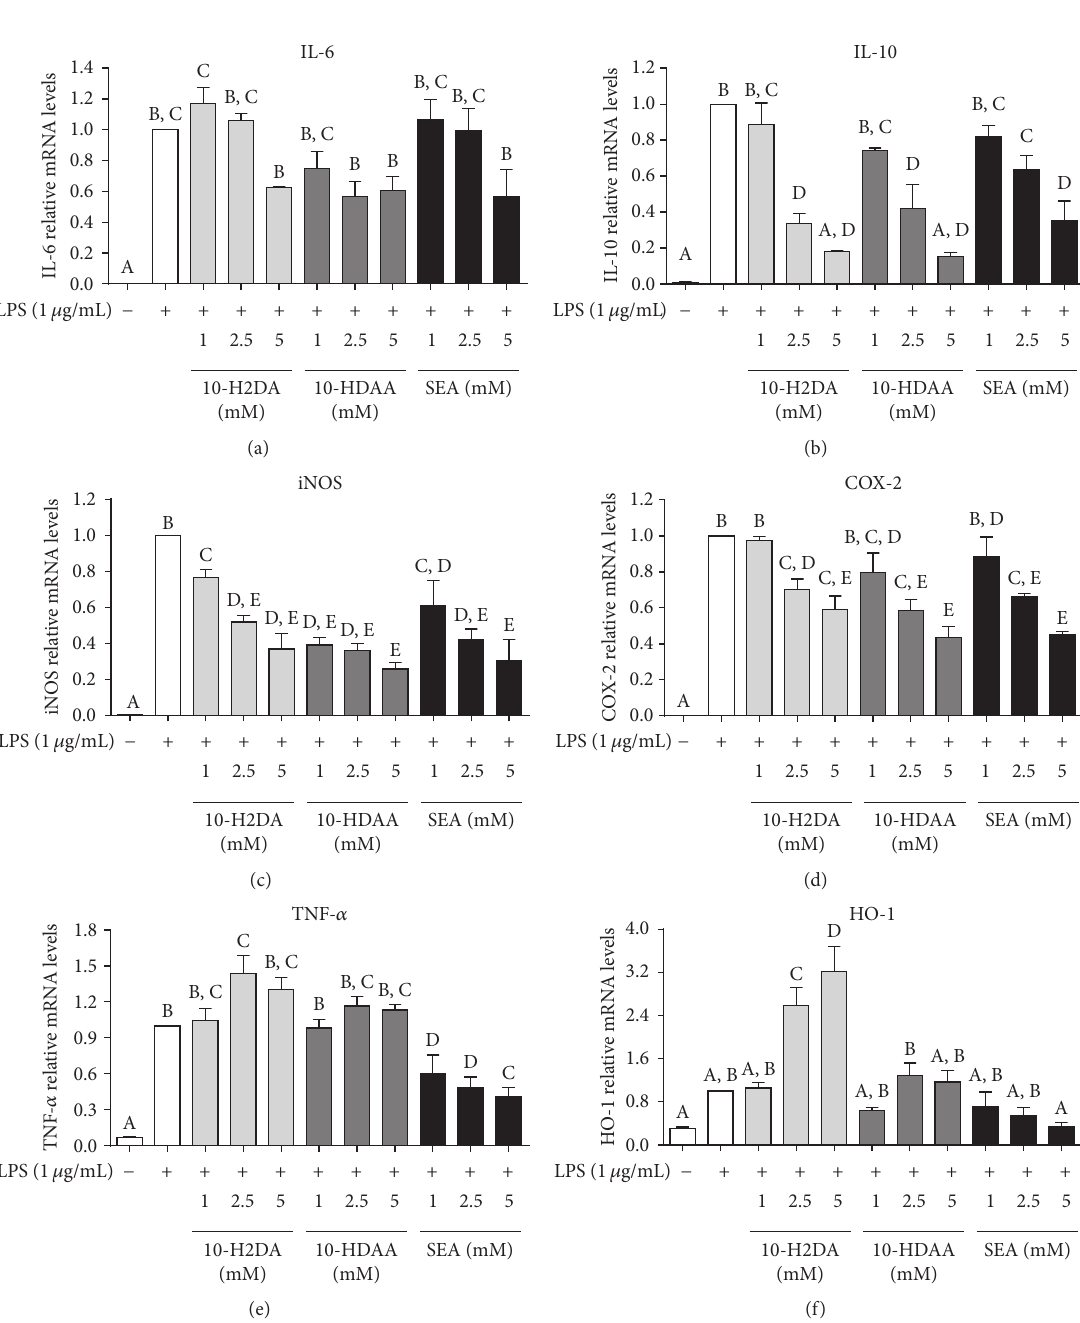
Figure 5: Effects of pretreatment with 10-H2DA, 10-HDAA, and SEA on the mRNA expression of key inflammatory-mediators and cytokine genes in LPS-stimulated RAW 264.7 cells. Effects of 10-H2DA, 10-HDAA, and SEA on the mRNA expression of key inflammatory-mediators and cytokine genes in LPS-stimulated RAW 264.7 cells. Cells were pretreated with 10-H2DA, 10-HDAA, and SEA in designed concentrations for 1h and then stimulated with LPS (1 𝜇 g/mL) for 30 min. The mRNA levels of IL-6 (a), IL-10 (b), iNOS (c), COX-2 (d), TNF- 𝛼 (e), and HO-1 (f) were quantified using qRT-PCR and normalized to GAPDH and the levels of gene expression in the LPS group were set to 1. Data shown represent means ± SEM values from three independent experiments. One-way ANOVA with the Student–Newman–Keuls method was performed to compare all groups; means with different letters are significantly different ( 𝑃 < 0.05